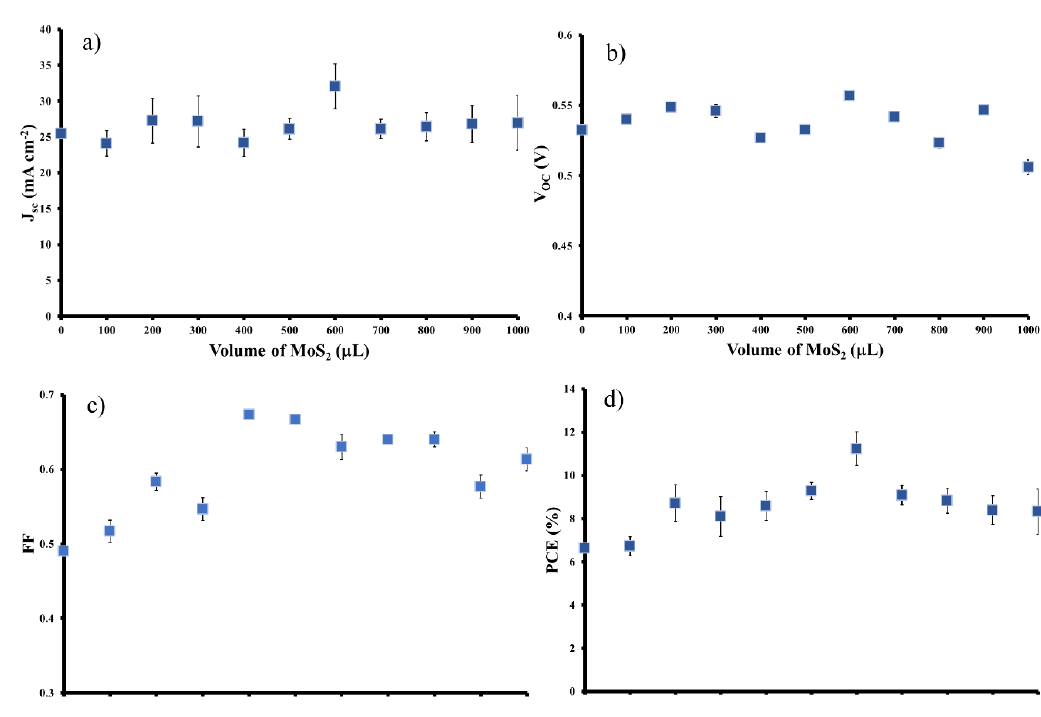
Figure 5. Layered SWCNT/MoS 2 /n-Si solar cells parameters ( a ) J sc ; ( b ) V oc ; ( c ) Fill factor (FF) and ( d ) Photoconversion efficiency (PCE) extracted after all three chemical treatments.